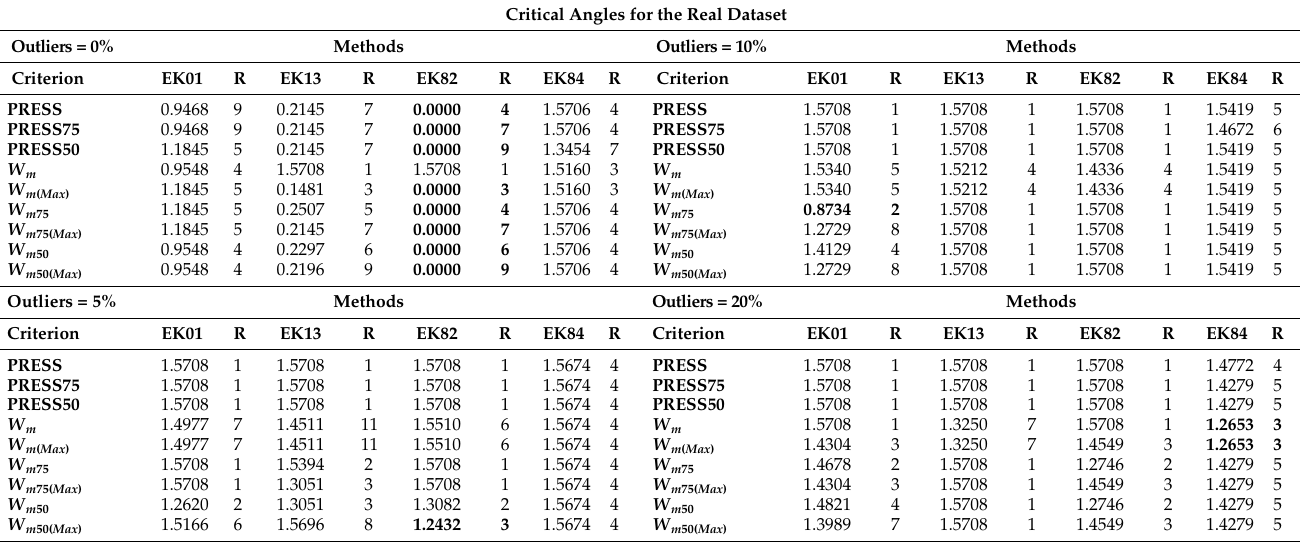
Table 4. Critical angles for the real